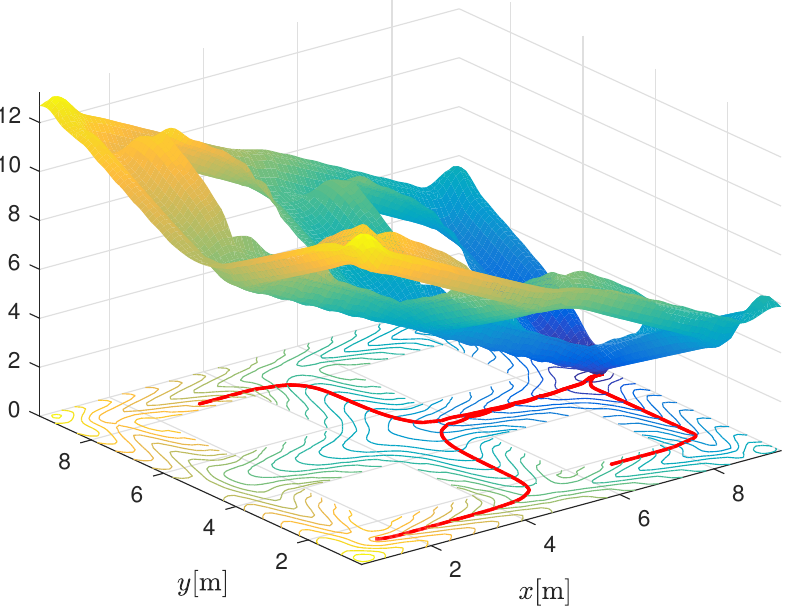
Figure 6. 3D view of the interpolated navigation function N ( x , y , ϕ ) . For clarity, e ( ϕ ) is set to zero in Equation (3). Three paths are drawn from different starting points, following the negative gradient towards the goal location with the lowest potential